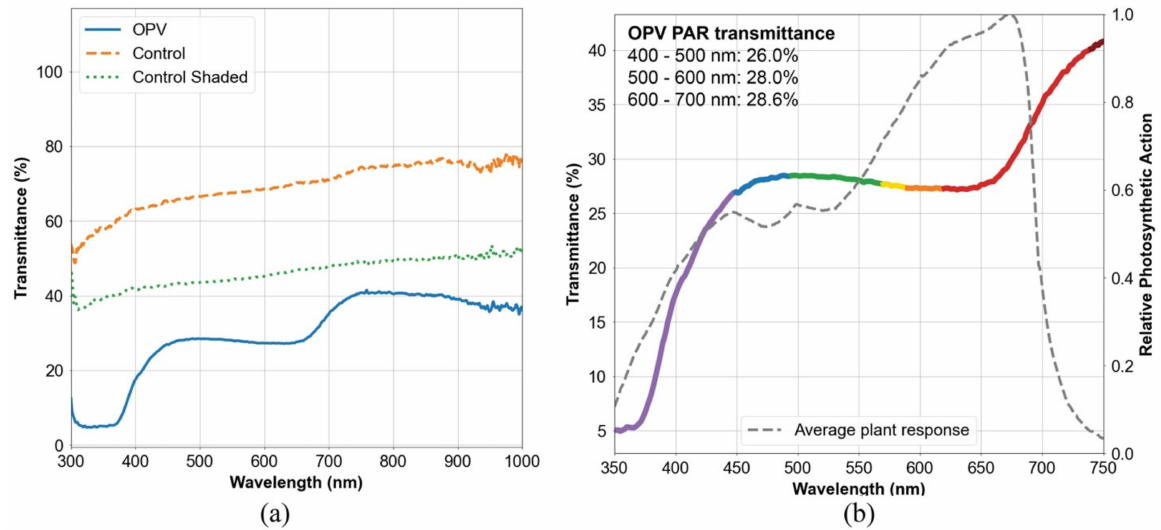
Figure 7. Canopy-level lighting quality in OPV and Control sections: ( a ) comparing OPV and Control sections with and without a shade net installed, measured at midday with a clear sky; ( b ) comparing the light transmittance in the PAR region in the OPV section to the relative photosynthetic action (efficiency), shown in the dashed gray line, which was adapted from McCree